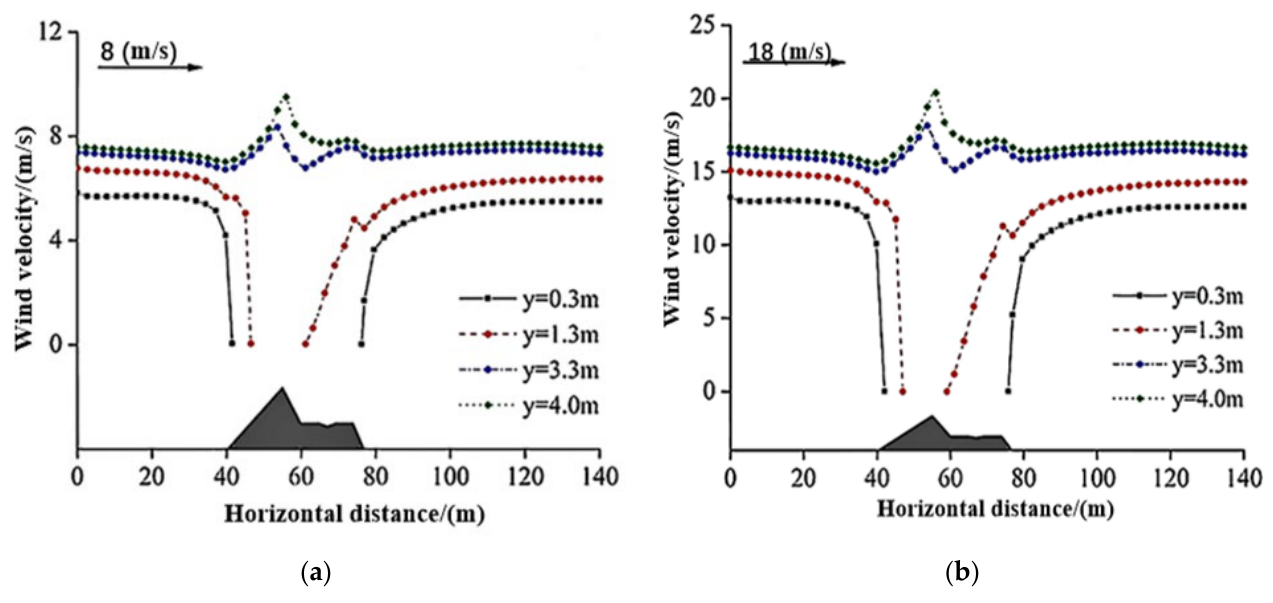
Figure 10. Horizontal wind speed at different heights from the surface of the embankment in flat terrain. ( a ) Wind speed of 8 m/s; ( b ) Wind speed of 18 m/s.